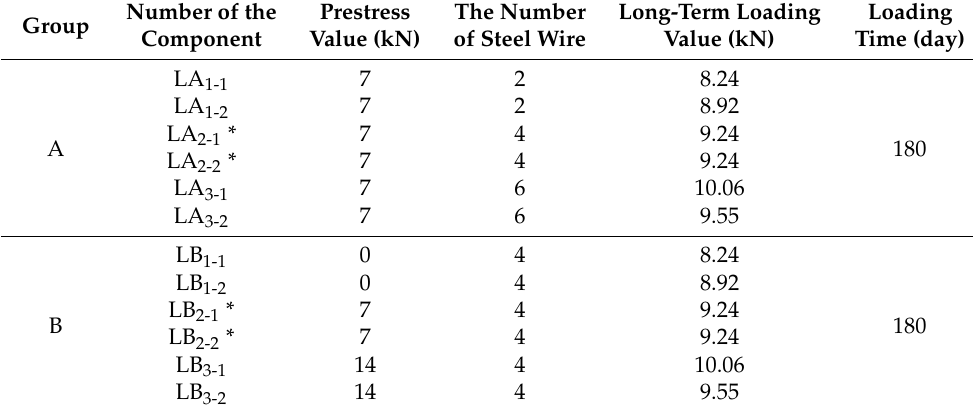
Table 2. Groups and information of specimens.